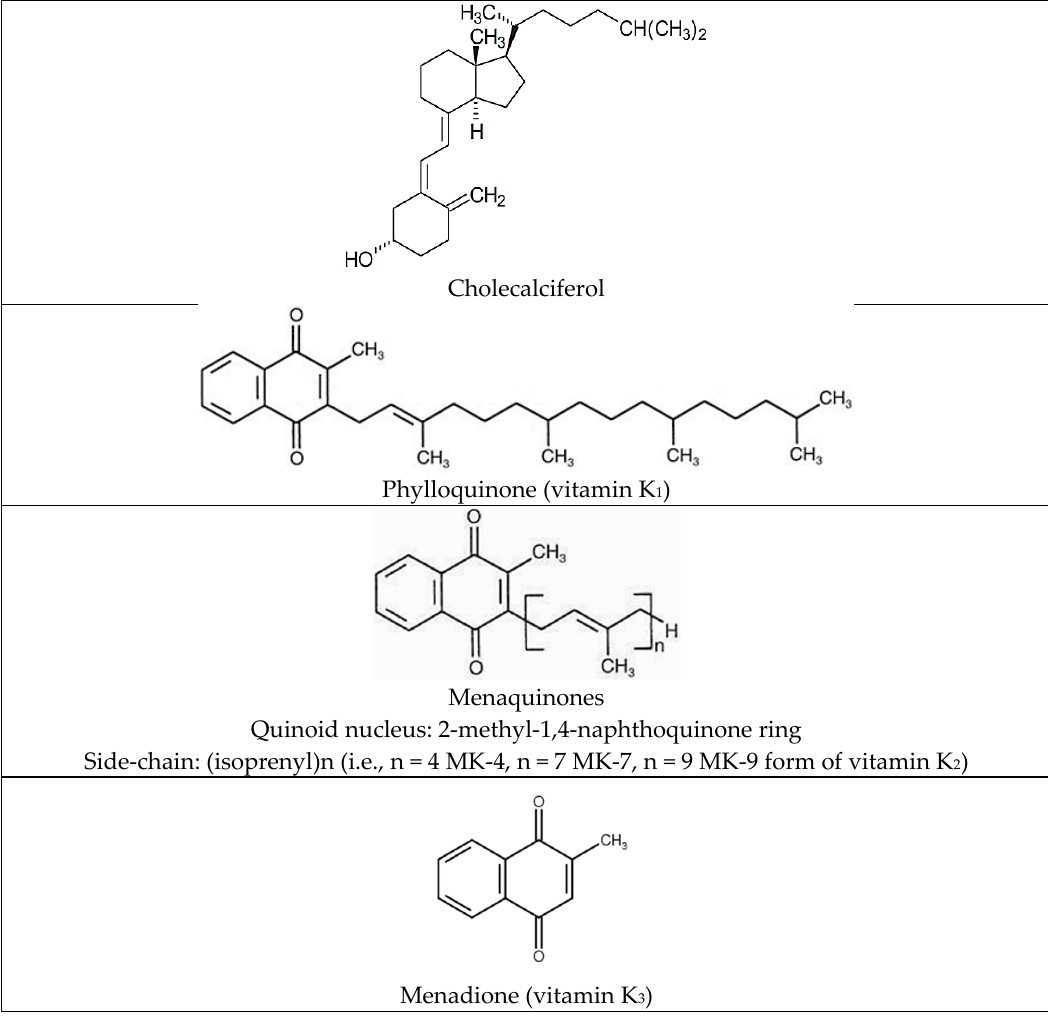
Figure 1. Chemical structure of analyzed compounds.